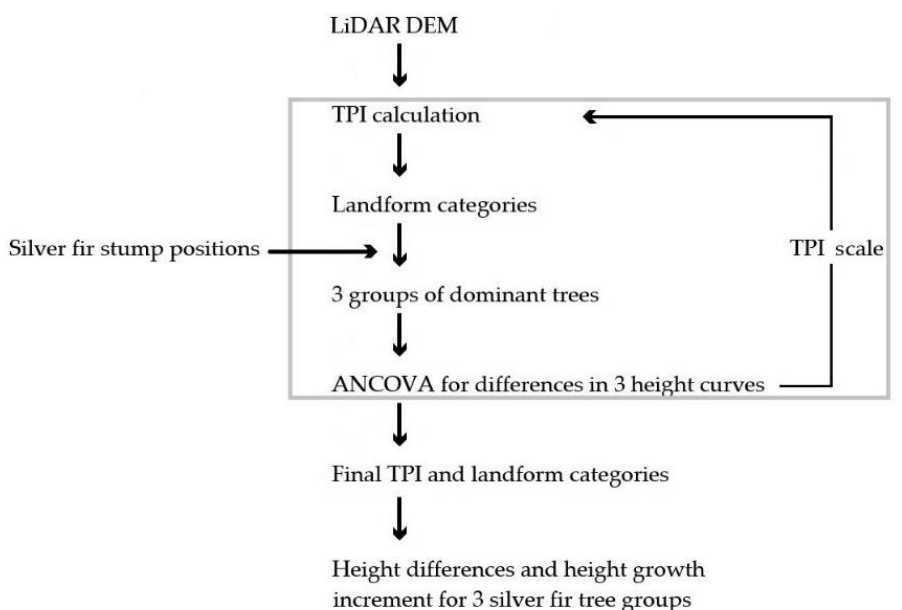
Figure 5. Flowchart of the methodology used for delineation of landform categories and modelling dominant silver fir height growth.